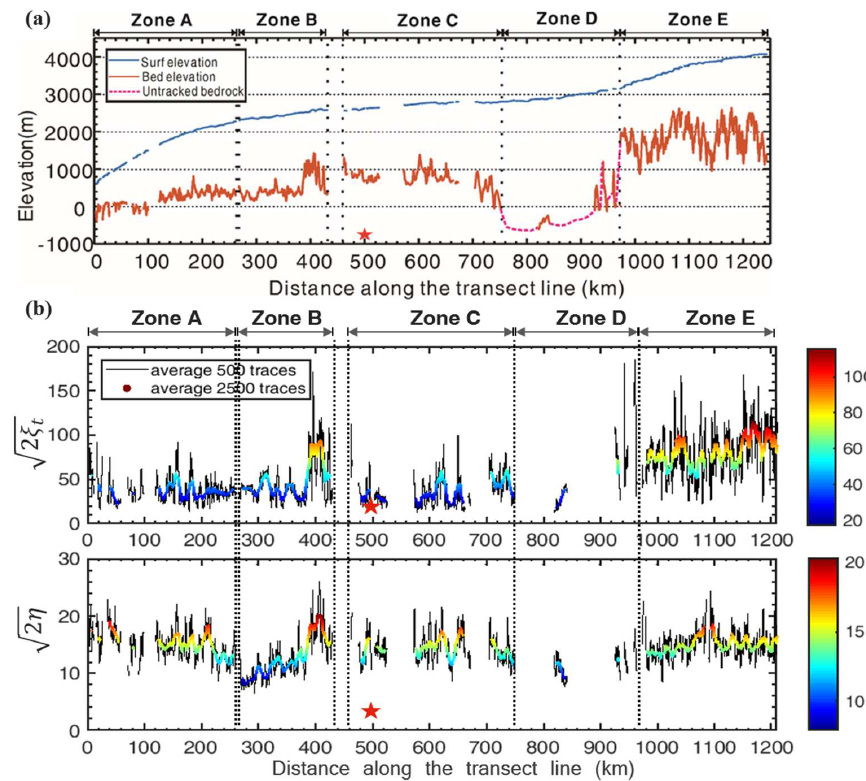
Figure 5. ( a ) Surface and bed elevation, ( b ) basal roughness from Zhongshan to Dome A. The black line indicates the result from 500-trace moving windows, and the color scatter is the result from 2500-trace moving windows. The red star marks the location of Taishan Station.